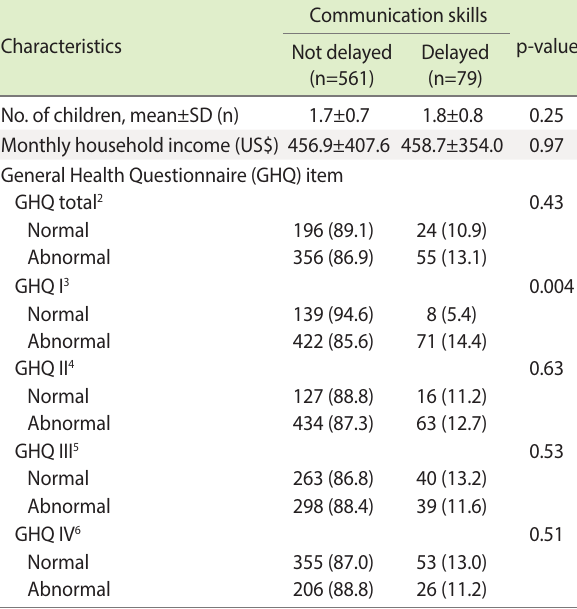
Table 3. The frequency distribution of the mothers’